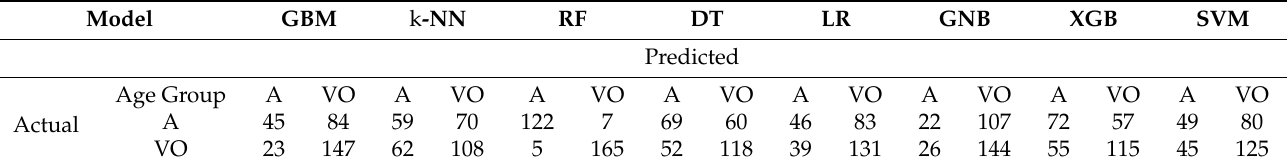
Table 16. Age group classifier’s CMs.